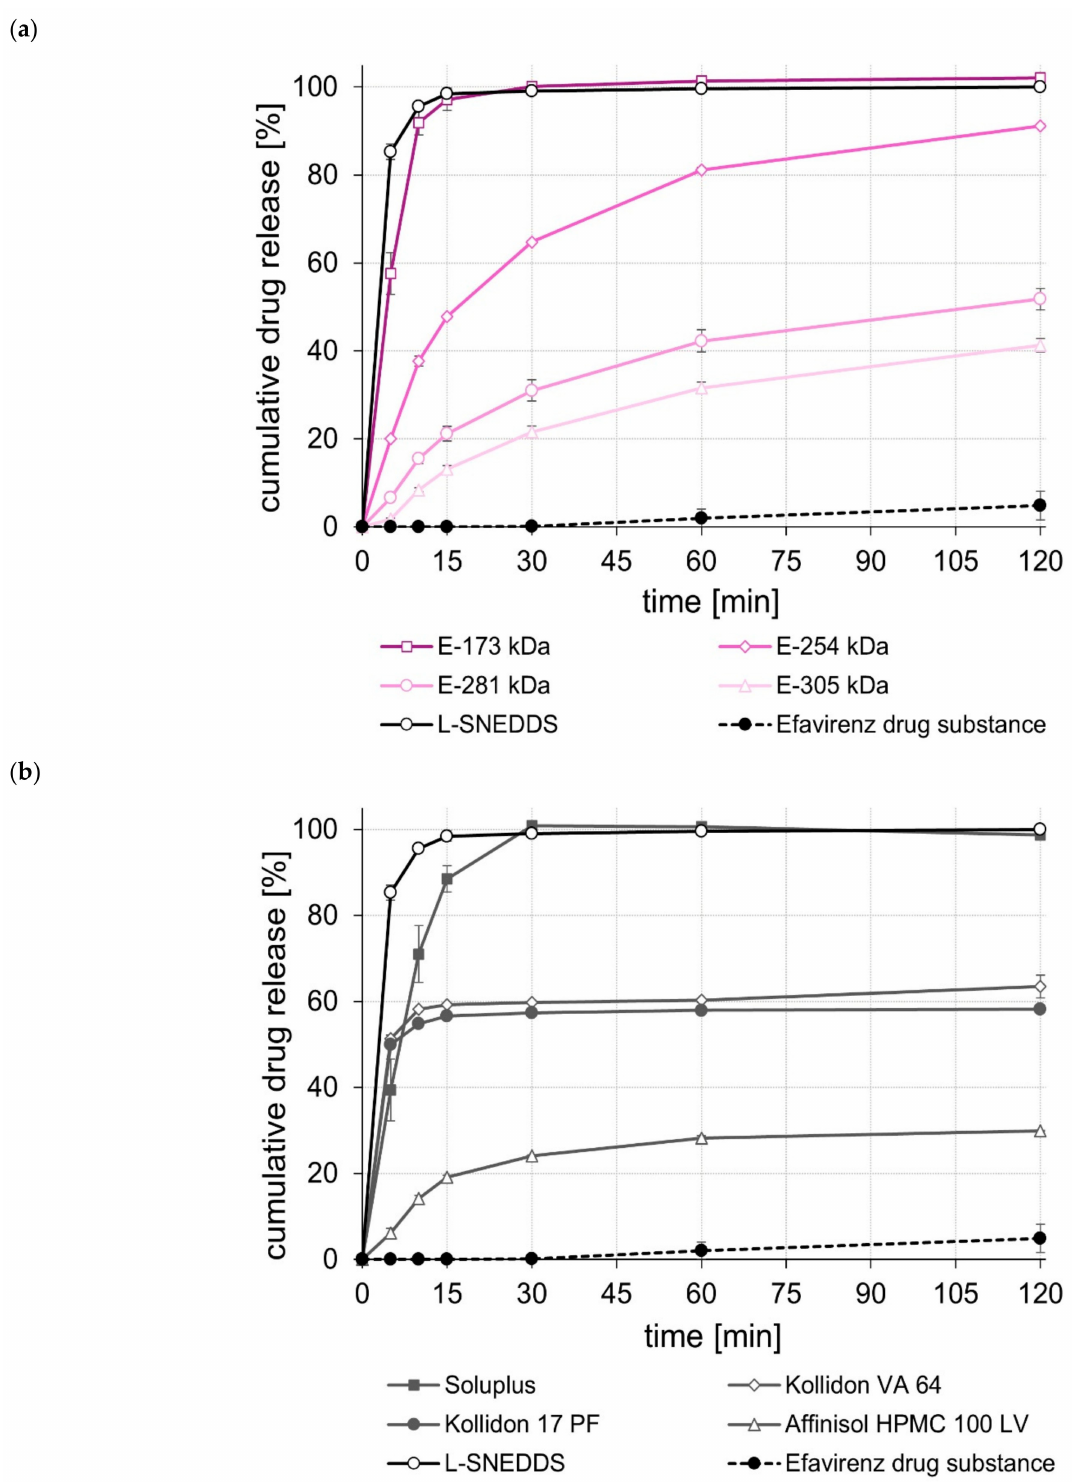
Figure 2. Dissolution profiles of the efavirenz drug substance and efavirenz L- and S-SNEDDS based on ModE ( a ), as well as the efavirenz drug substance and efavirenz L- and S-SNEDDS based on other marketed (co)polymers ( b ) in 500 mL 0.1 M HCl in USP apparatus II. Each value designates the mean ± S.D. ( n =